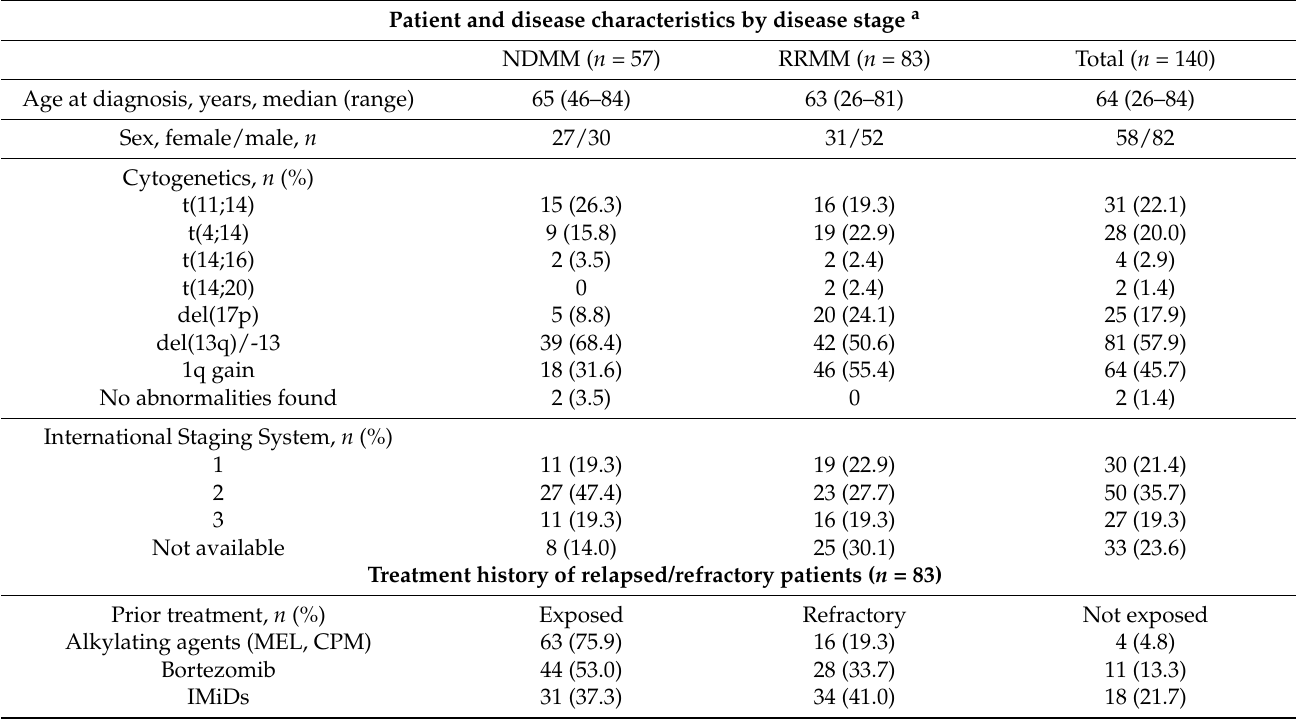
Table 1. MM patient and Disease Characteristics and Treatment History in the FIMM